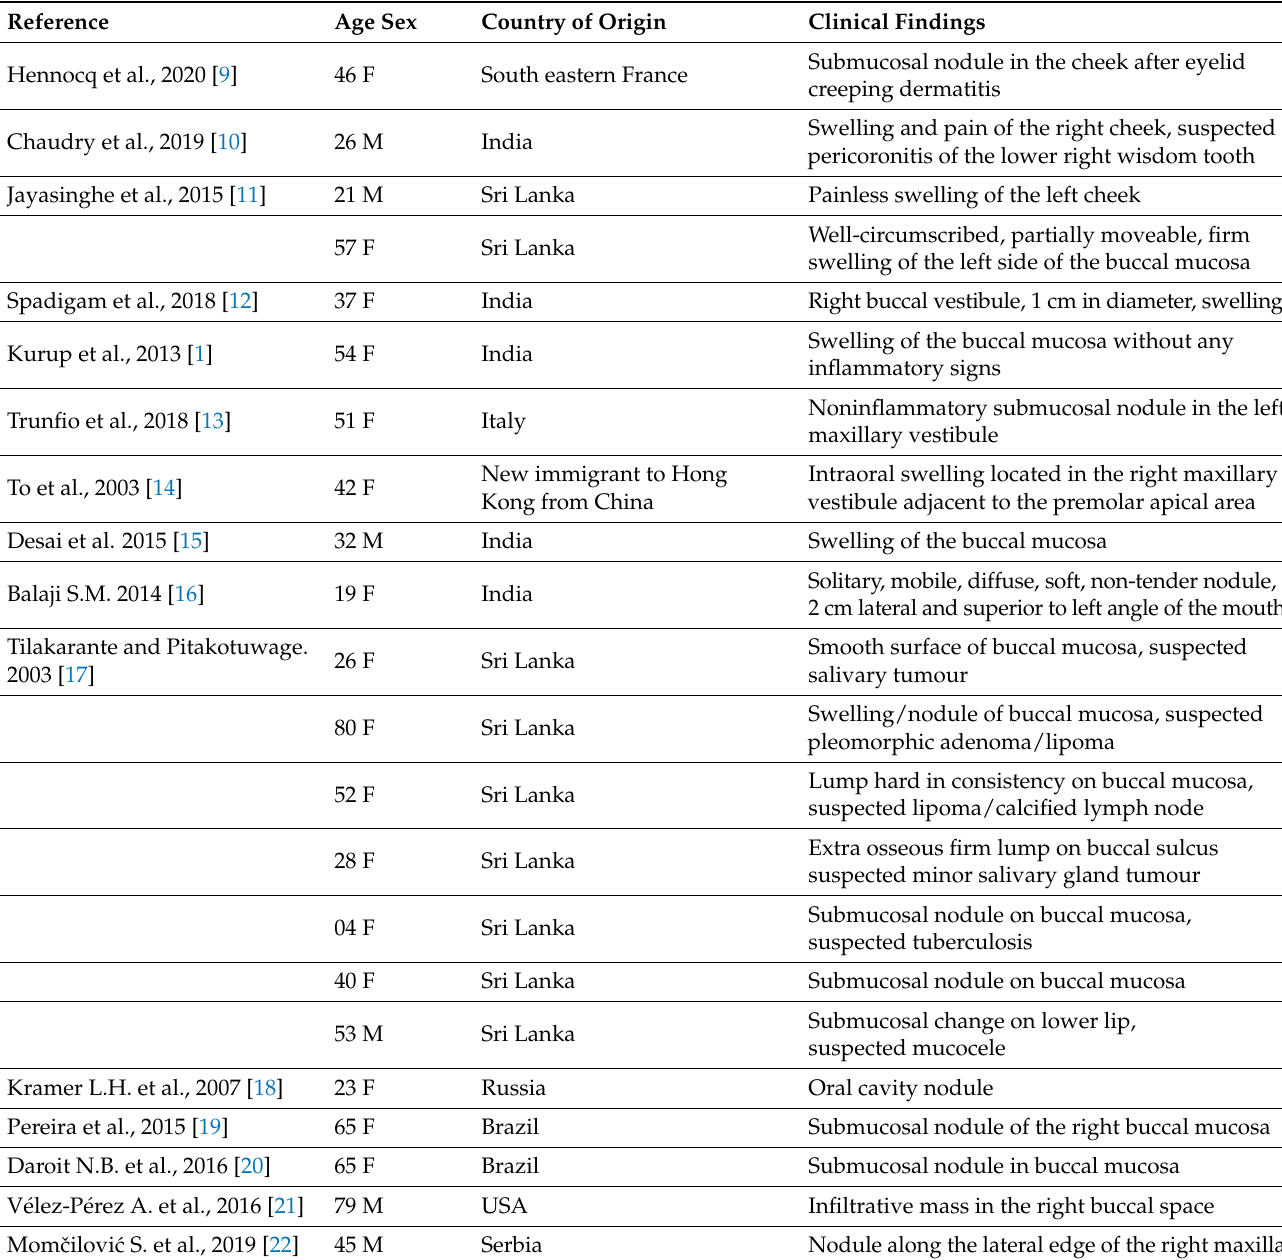
Table 1. Dirofilaria repens infestations involving oral